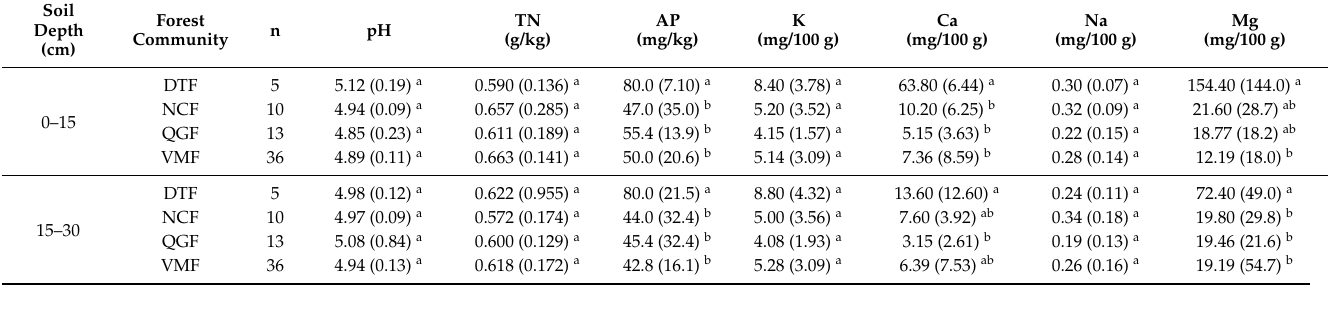
Table 4. Soil chemical properties in the Diospyros toposia forest (DTF), Nothaphoebe condensa forest (NCF), Quercus glauca forest (QGF), and Vatica maingayi forest (VMF). Values in parenthesis are the standard deviations from the mean. Different lowercase letters indicate statistical significance between forest community types at α = 0.05. Values in parenthesis are the standard deviations from the mean. Abbreviations: TN—total nitrogen, AP—available phosphorus, K—extractable potassium,